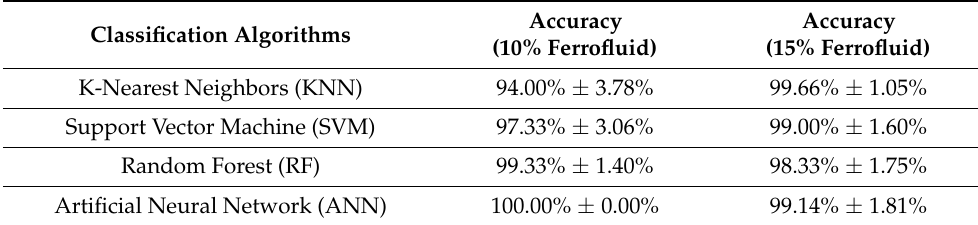
Table 4. Machine learning algorithm accuracies to detect the five different postures of the spine replica with the 10% ferrofluid and 15% ferrofluid soft